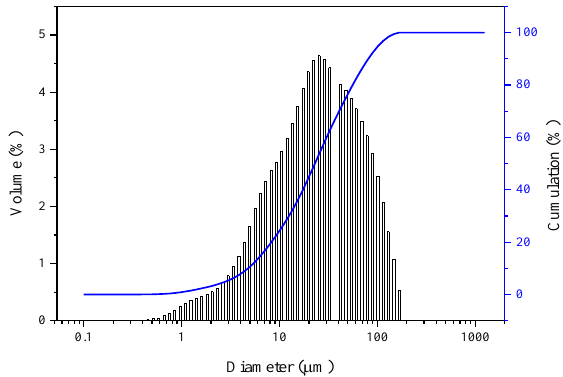
Figure 2. Particle size distribution of FA.